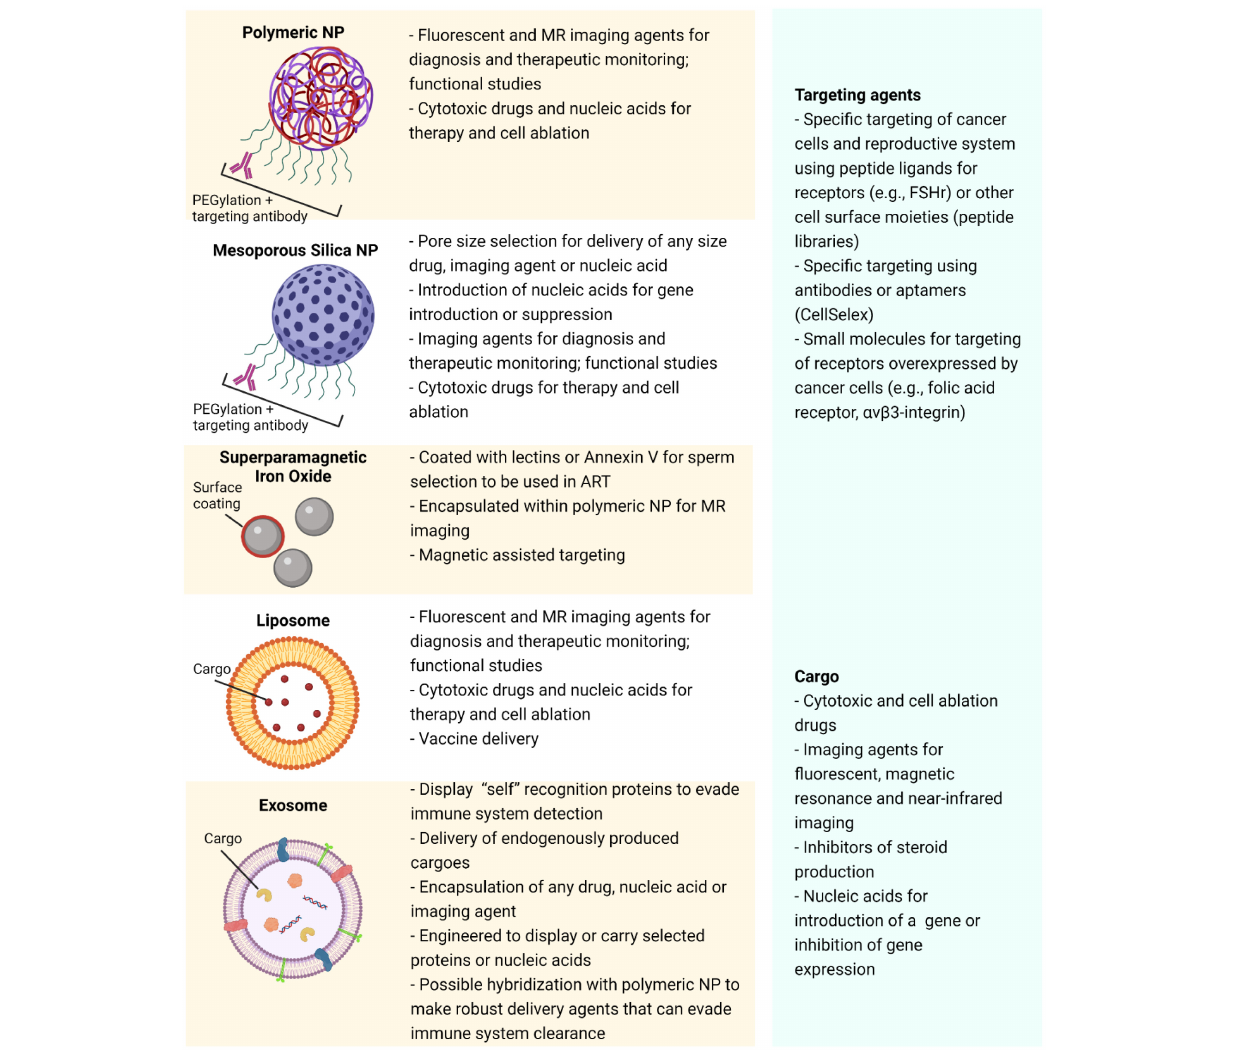
FIGURE 3 | Schematic diagram of some of the more commonly studied nanoparticles highlighting a selection of their properties, possible applications, payloads and targeting